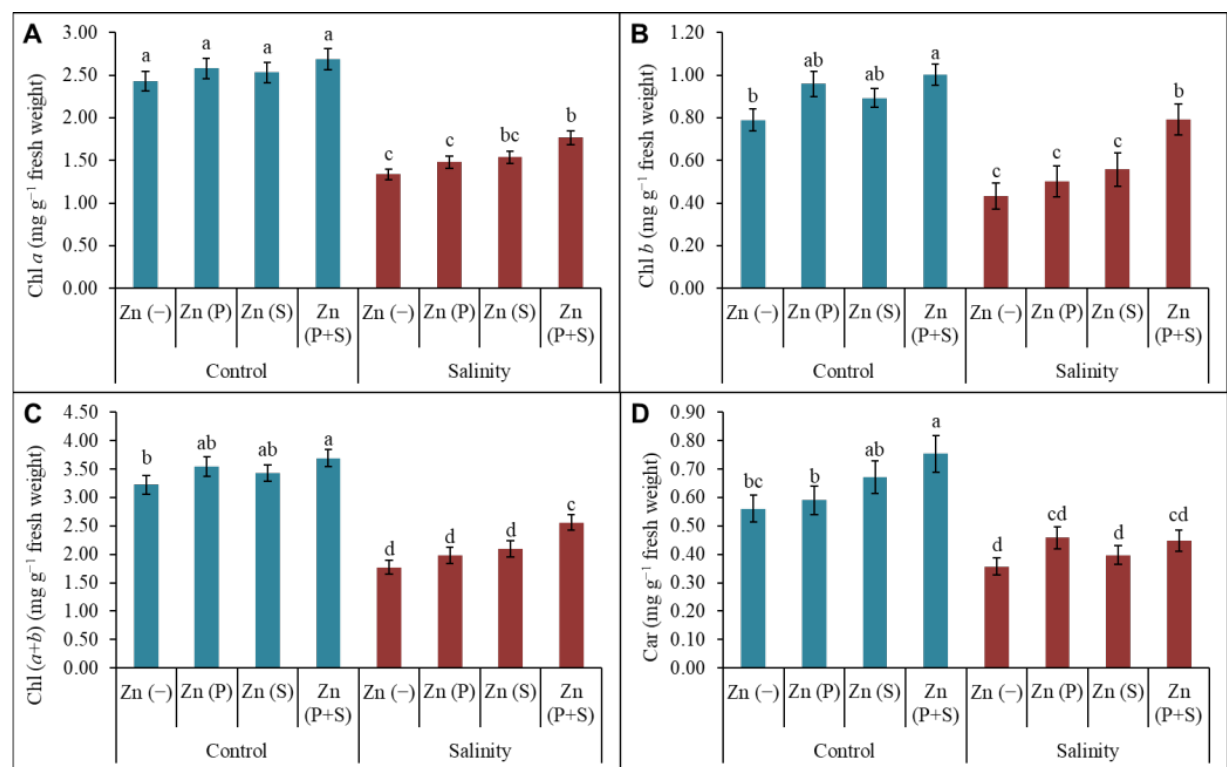
Figure 2. Chl a ( A ). Chl b ( B ), Chl ( a + b ) ( C ) and Car ( D ) content of soybean plants induced by Zn supplementation. Twenty five-day-old plants were subjected to salt (150 mM NaCl) and supple- mented with Zn (1 mM ZnSO 4 .7H 2 O). P and S indicate seed priming and foliar application with Zn, respectively. Control treatments were grown with water. Mean (± SD) was calculated from three replicates for each treatment. Different letters of bars indicate significant differences at p ≤ 0.05 ap- plying Tukey’s HSD test.